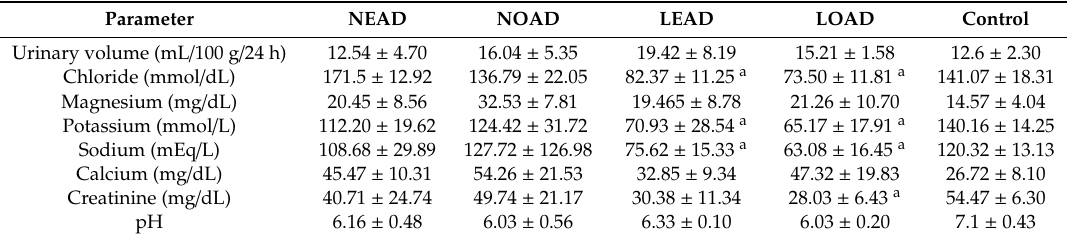
Table 1. Urinary parameters in the various groups over 60 days of